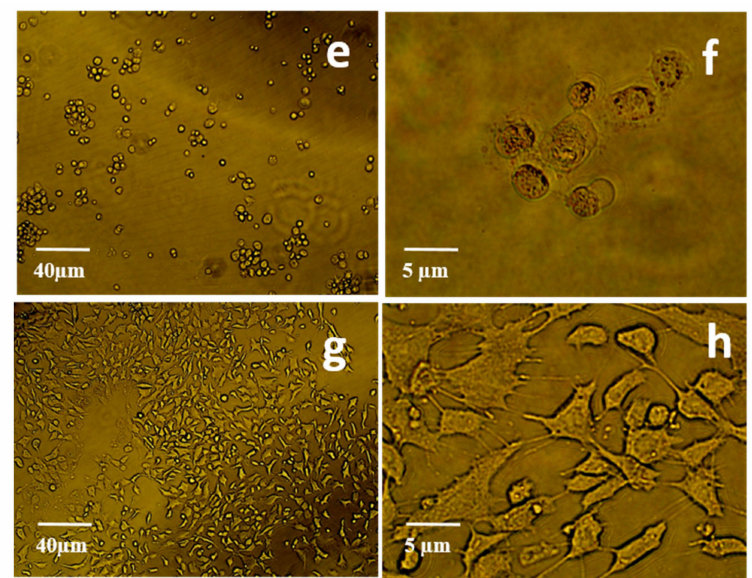
Figure 3. Representative microscopic images of 4T1-Luc2 cells incubated with or without aptamers. ( a , b ): anti-VCAM-1 ssDNA aptamers (11R6) treated cells; ( c , d ): anti VCAM-1 ssDNA truncated aptamers (A11R6) treated cells ( e , f ): anti-IL4R α RNA aptamers (Cl42RNA) treated cells; ( g , h ): untreated